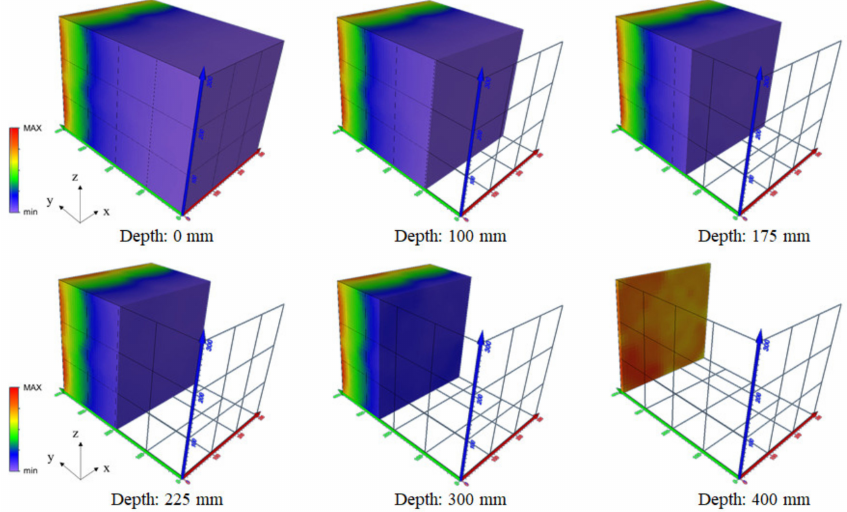
Figure 24. 3D SIBIE result with LDV signal detection for intact concrete